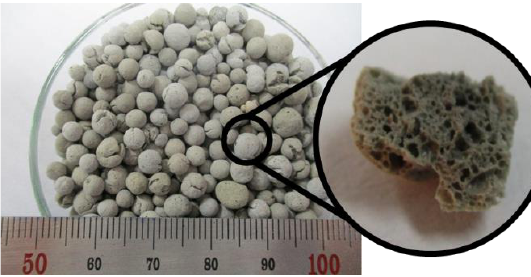
Figure 1. Shape of waste glass beads (WGBs). Table 1. Physical properties of WGBs.